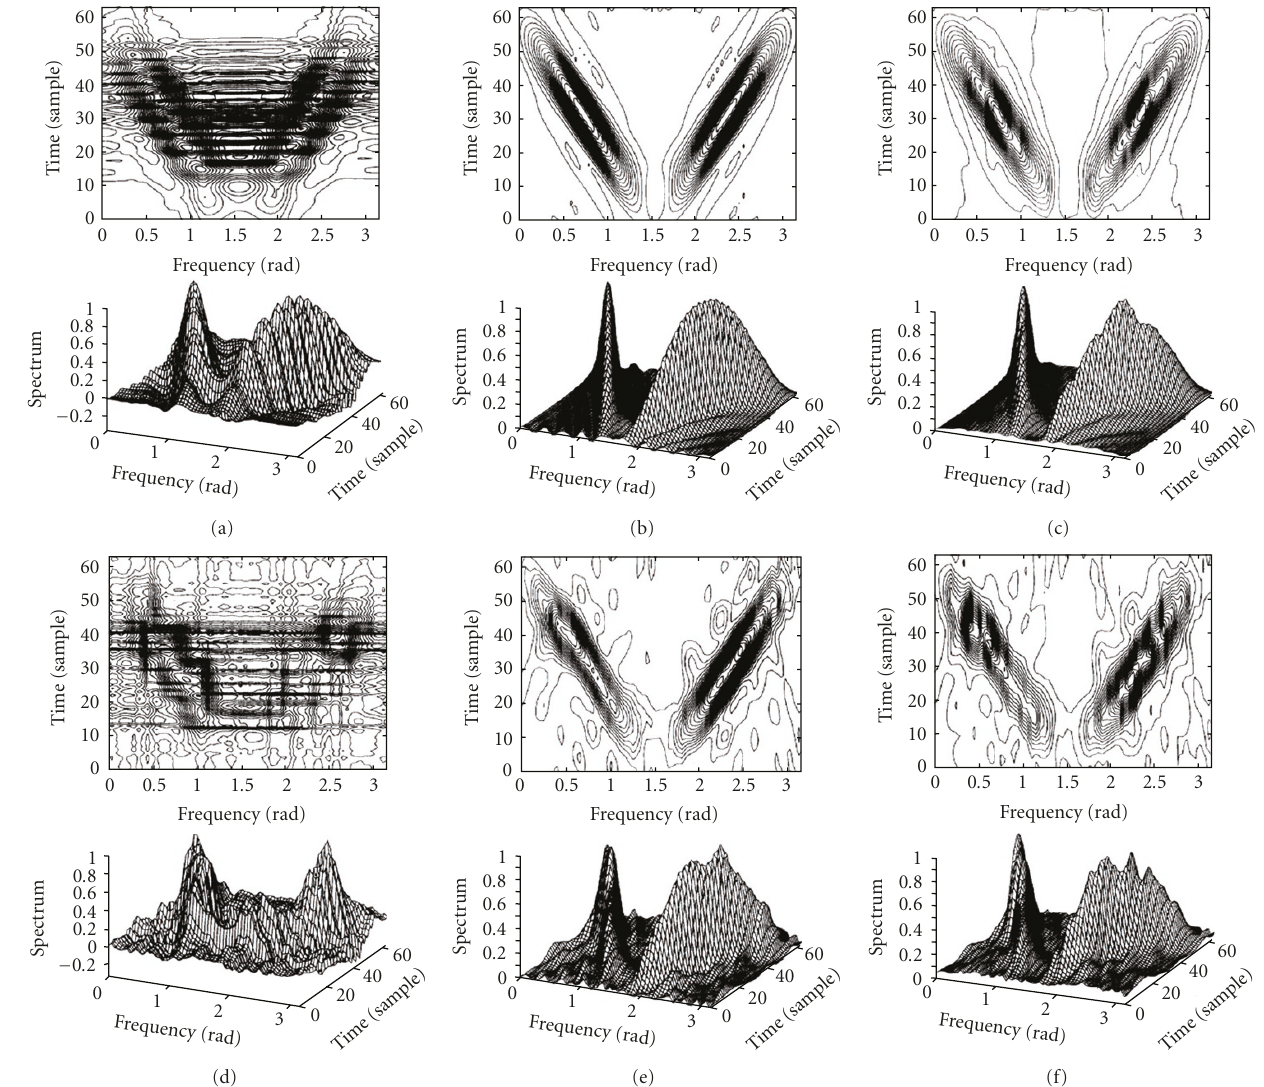
Figure 4: Example signals [51]. Signal 1 composed of two chirps, (a) BD using exponential kernels, (b) EP spectral estimate, and (c) DASE spectral estimate. Signal 2 composed of two chirps with additive Guassian white noise (SNR = 24 dB), (d) BD using exponential kernels, (e) EP spectral estimate, and (f) DASE spectral estimate (all adopted from Kayhan et al. [51]).